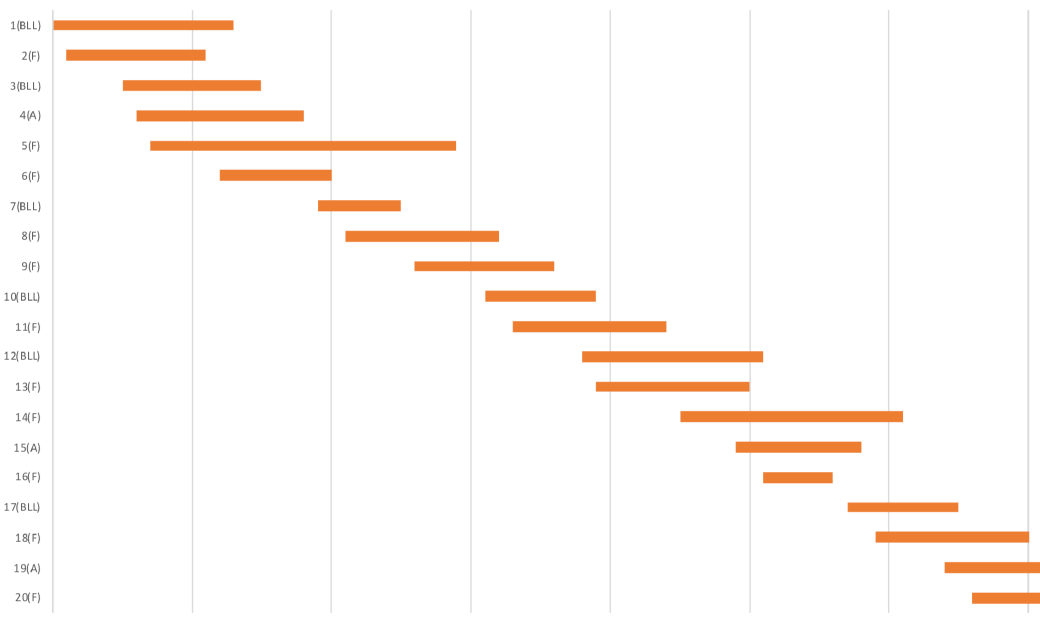
Figure 6. Gantt diagram of Scenario A when CLARISSE is not active and, consequently, the interferences are not avoided. The length of diagram corresponds to the workflow makespan with a value of 14.889